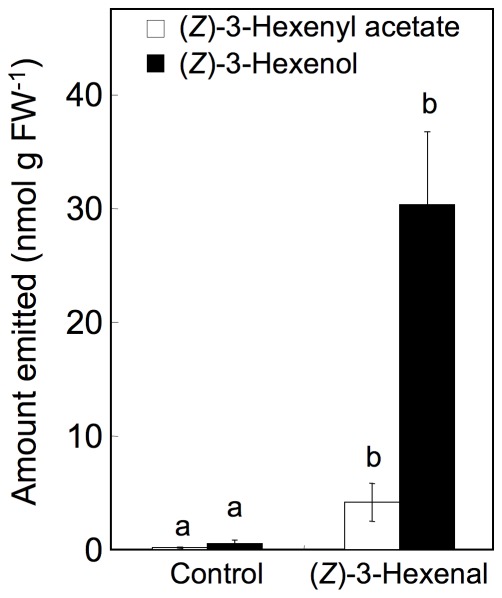
Conversion of (Z)-3-hexenal in intact Arabidopsis (Col-0).Intact Arabidopsis (Col-0) plants were exposed to (Z)-3-hexenal vapor (1.0 nmol cm−3), transferred into a fresh glass container, and the amounts of (Z)-3-hexenyl acetate (white bars) and (Z)-3-hexenol (black bars) emitted from the plants were quantified. Control plants were exposed to CH2Cl2 vapor (carrier solvent for volatiles). Error bars represent SE (n = 3). Data were analyzed by Tukey's test. Different letters above the bars indicate significant differences among treatments in the emission of each compound (P<0.05).